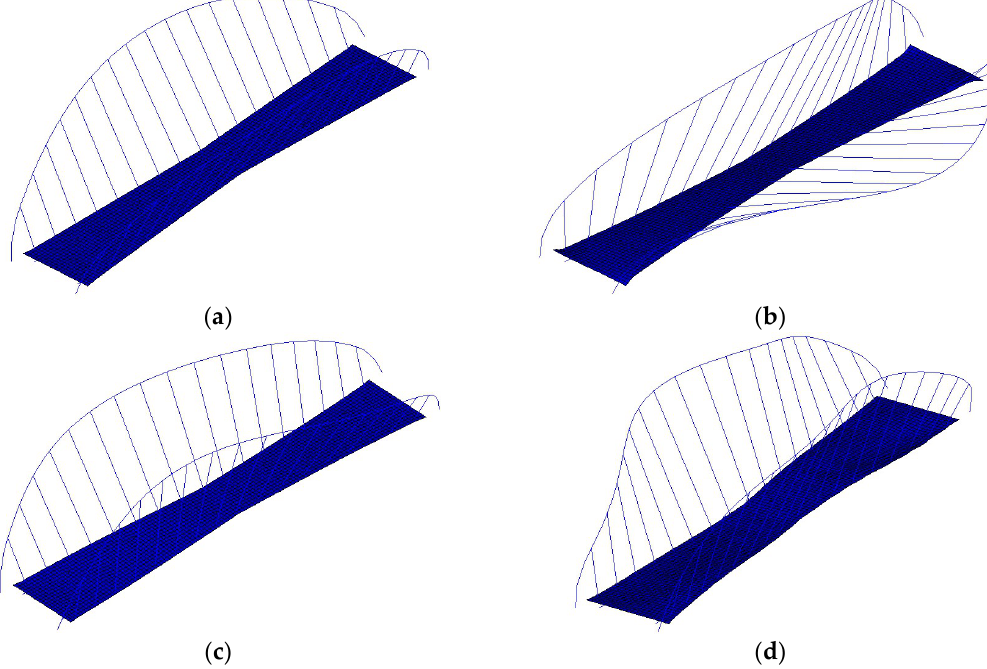
Figure 9. Mode dominated by the arch: ( a ) the 1st mode (0.93 Hz); ( b ) the 2nd mode (0.99 Hz); ( c ) the 5th mode (2.50 Hz); ( d ) the 8th mode (5.22 Hz).